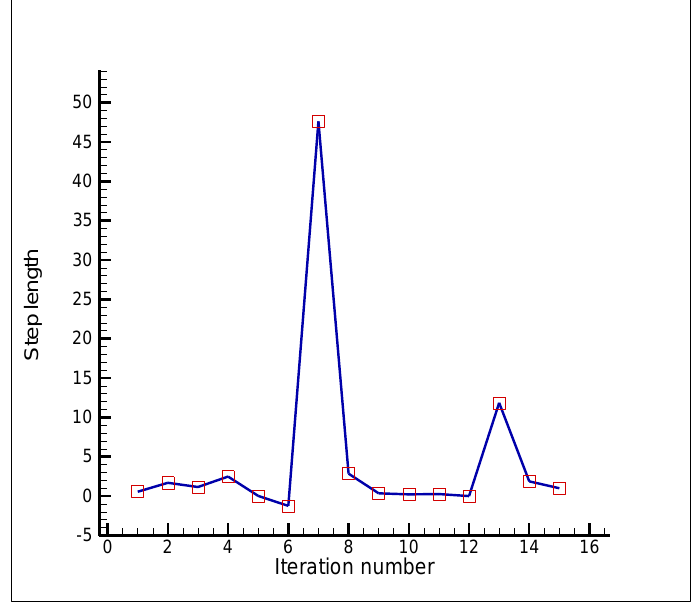
Figure 12. Exact step length value during the shape optimization process.